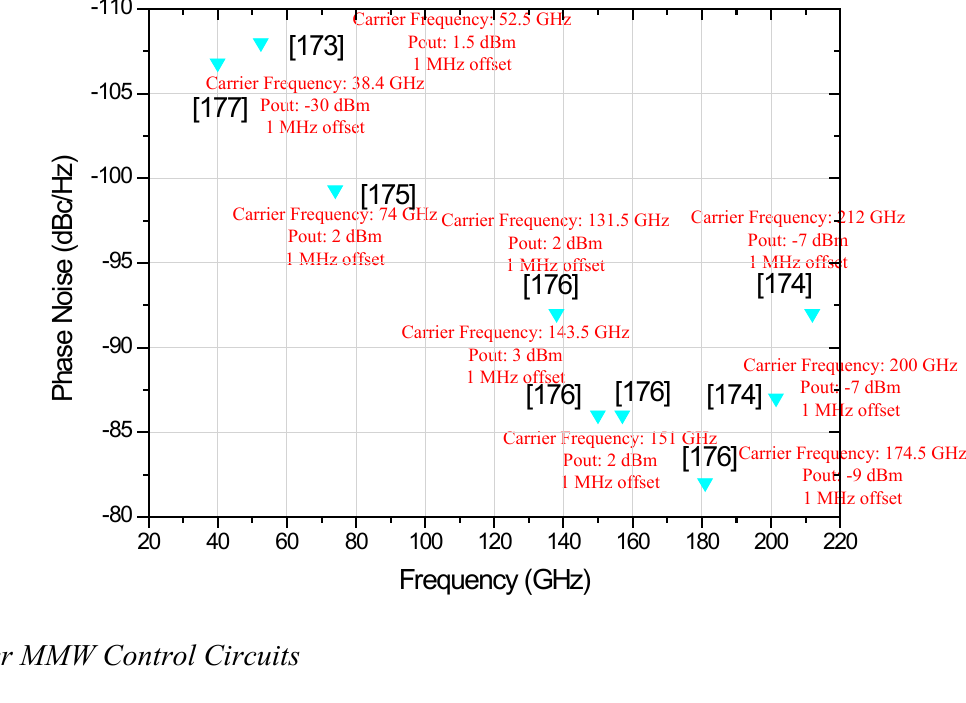
Figure 17. Phase noise of the recent published MMW SiGe VCOs. Data is taken from